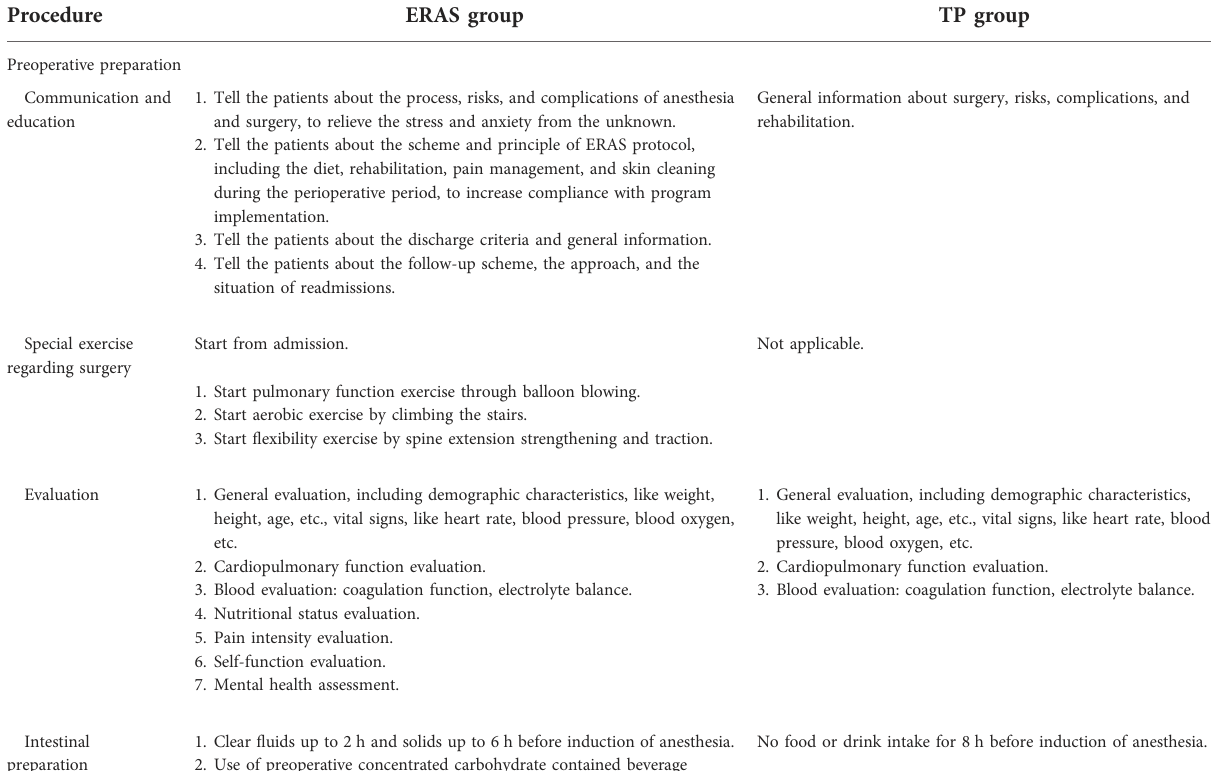
TABLE 1 The protocol of ERAS method and traditional